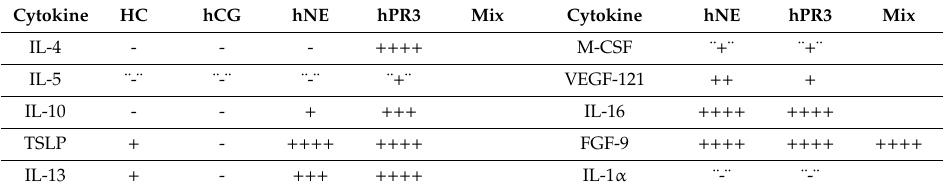
Table 1. Summary of the results from the cleavage analysis of cytokines and chemokines by hNE and hPR-3 and the mix of the three neutrophil proteases hNE, hPR-3 and hCG. The analysis is based on the SDS-PAGE analysis in Figures 1 and 2. (-) no cleavage activity was observed. ( + ) showed minor activity, ( ++ ) and ( +++ ) partial cleavage. ( ++++ ) complete or almost complete cleaved by the